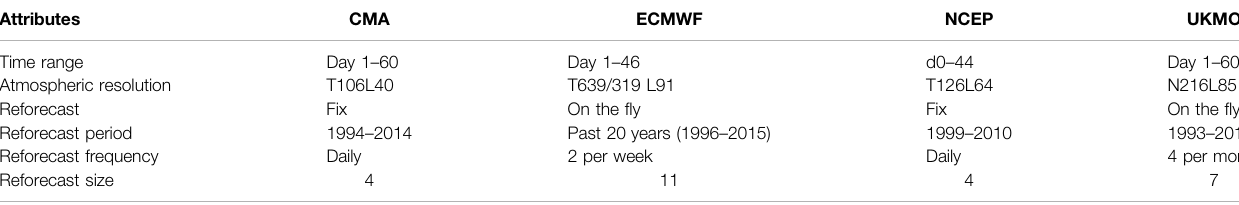
TABLE 1 | Reforecast attributes for the four systems from the WMO S2S database. Attributes